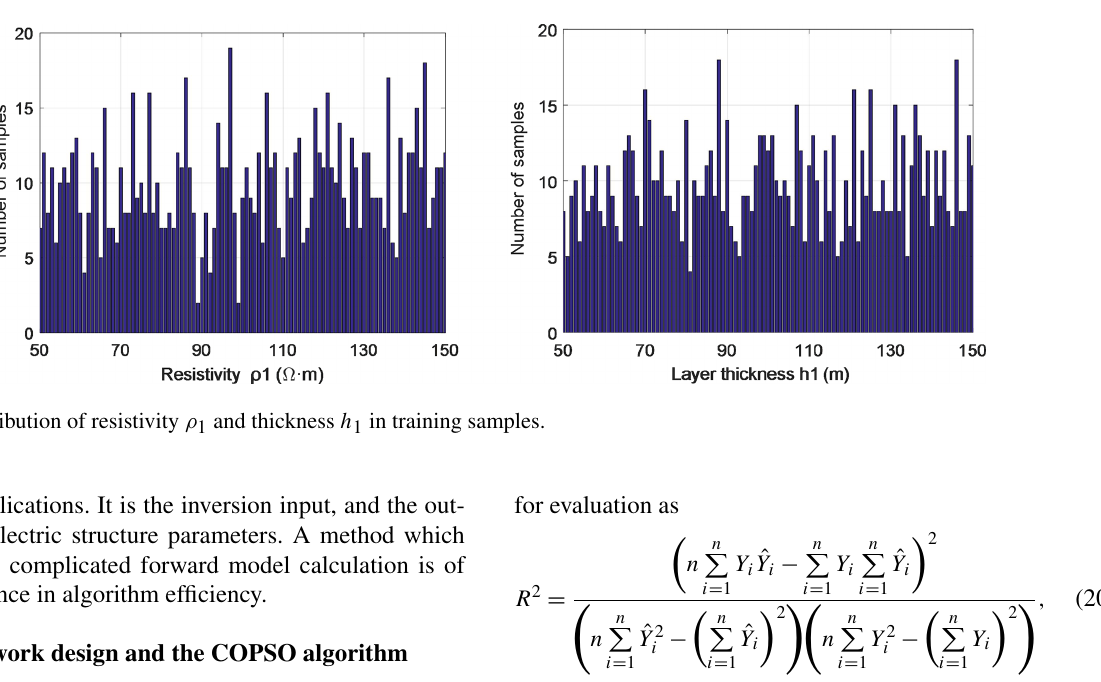
Figure 5. Influence of hidden-layer nodes on R 2 for different geoelectric models.